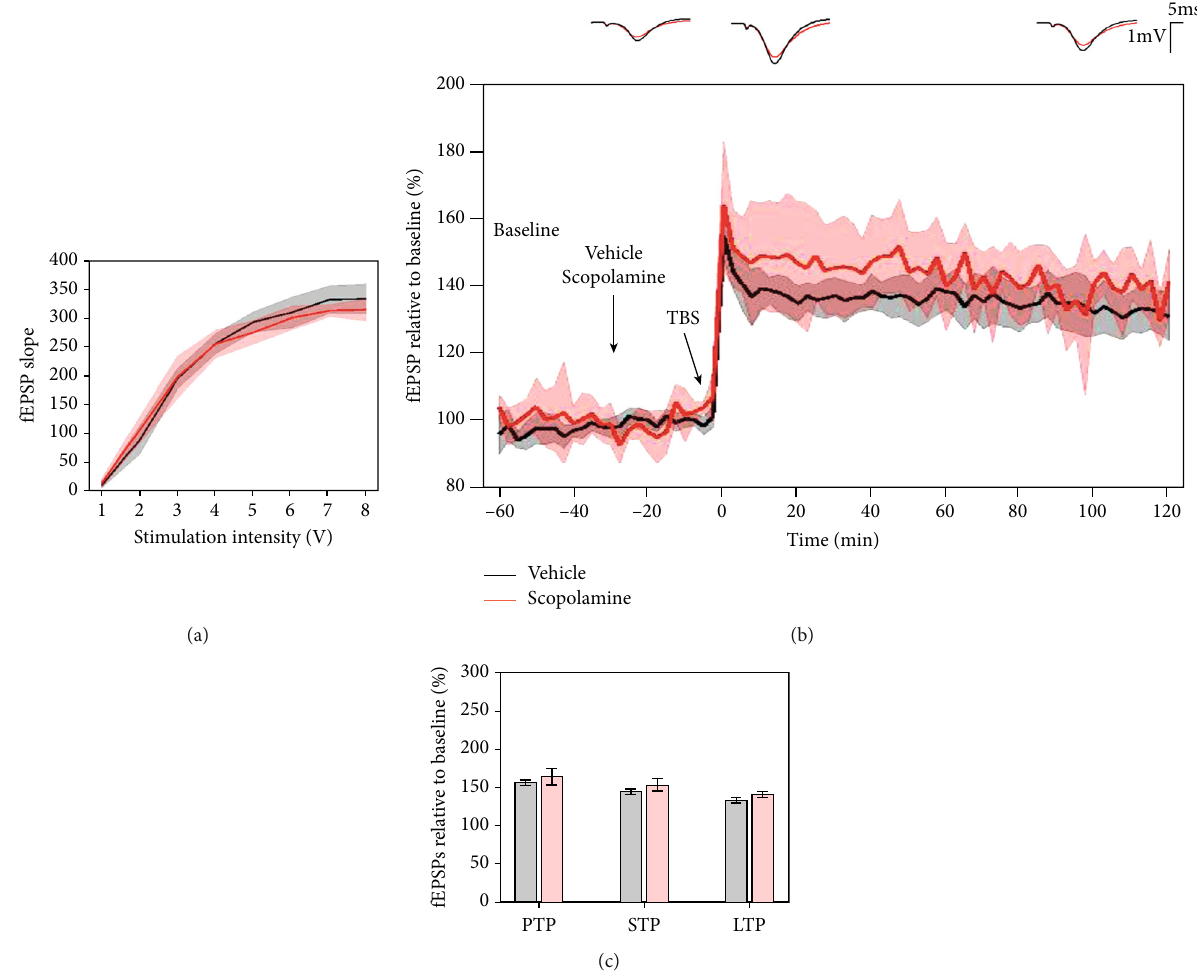
Figure 10: Scopolamine (0.64 mg/kg) had no signi fi cant e ff ect on the LTP response in LE rats. (a) Collective input/output curves between stimulation voltage and fEPSP slope overlap and show no signi fi cant di ff erence in basal synaptic excitability. (b) Both scopolamine (red, n = 7 ) and control, vehicle-treated (black, n = 10 ) subjects had an increase in fEPSP in response to 5 × TBS tetanisation; however, there was no signi fi cant di ff erence in the LTP response throughout the 2-hour posttetanisation. Values represent means ± 95 % confidence intervals . Outsets above LTP curves represent average waveform fi eld potentials during 30min baseline prior to tetanisation and 0-30min and 90-120 min posttetanisation. Horizontal bar: 1 mV; vertical bar: 5 ms. (c) PTP, STP, and LTP responses are presented as means ± 95 % confidence intervals